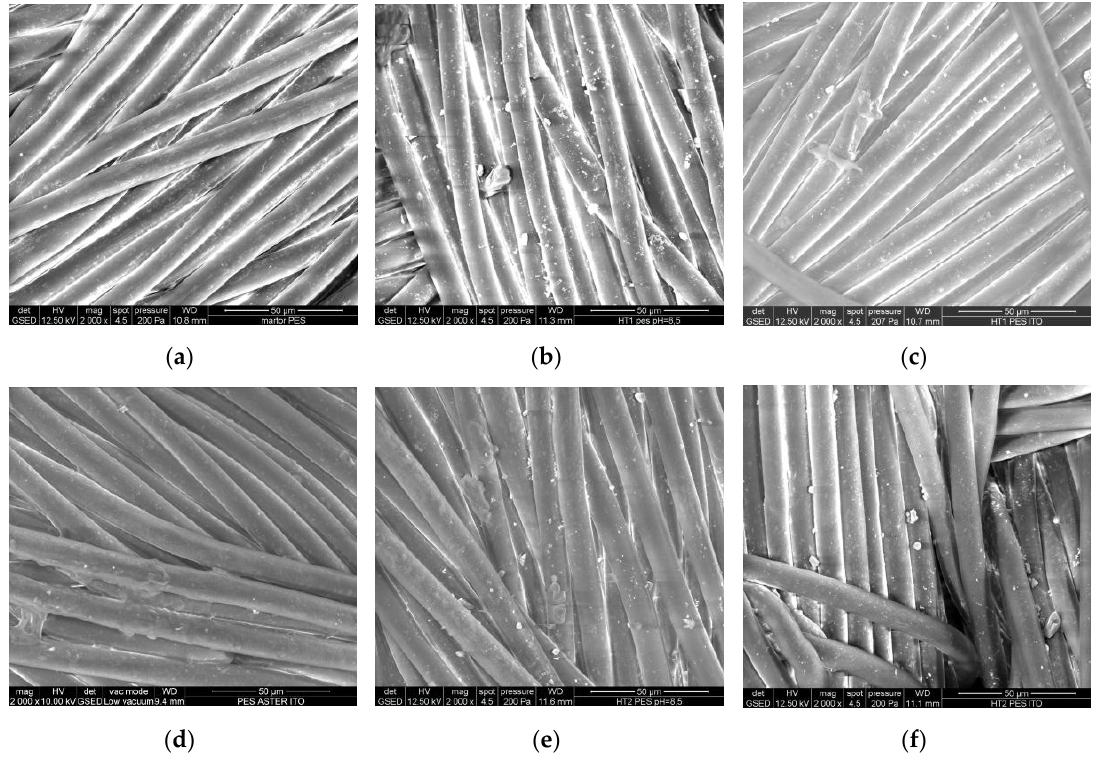
Figure 3. Scanning electron microscopy (SEM) images of polyester fabrics: Control-polyester (PES) fabric ( a ); HT1-PES fabric treated with TiO 2 -1% Fe–N (photocatalyst 1) ( b ); HT1 polyacrylic binder (ITO)-PES fabric treated with TiO 2 -1% Fe–N (photocatalyst 1) and ITO ( c ); PES ITO-PES fabric treated with polyacrylic binder (ITO) ( d ); HT2-PES fabric treated with TiO 2 -1% Fe–N (photocatalyst 2) ( e ); HT2 ITO-PES fabric treated with TiO 2 -1% Fe–N (photocatalyst 2) and ITO ( f ). Table 2. Physical characteristics of initial and coated polyester fabrics. Results for Each Sample Parameters